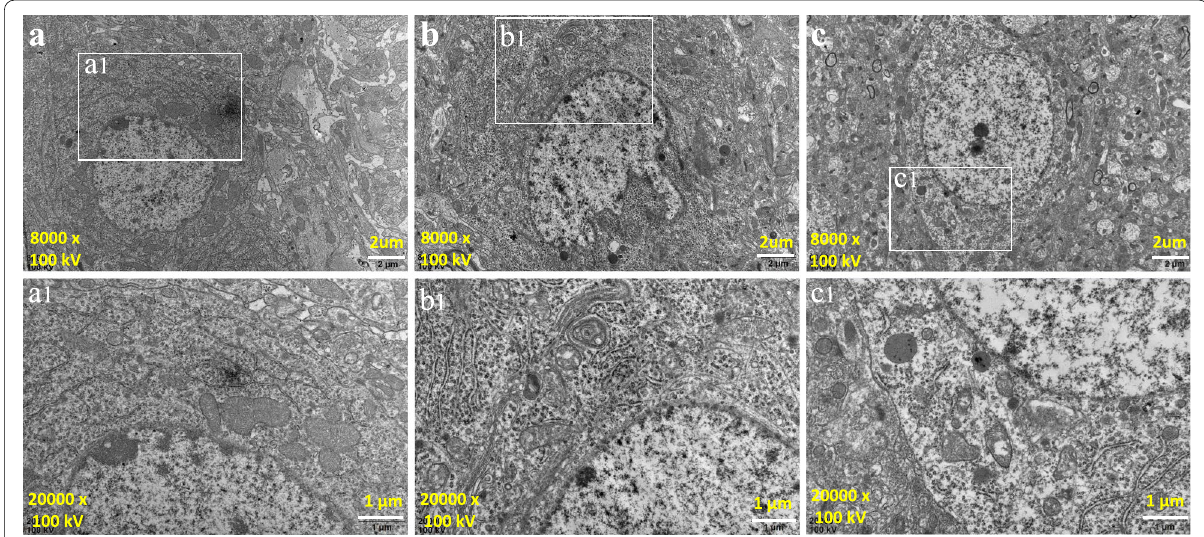
Fig. 6 Ultrastructural changes of nucleus and mitochondria in neurons. ( a ) Hippocampal neurons and mitochondria in control rats. ( b ) Ultrastructural changes of nuclei and mitochondria in hippocampal neurons. ( c ) Compared to the epilepsy model group, the 50 mg/kg OSI-906 group showed less damage to the mitochondria and nuclei. a , b and c are magnified 8,000 times, and a1 , b1 and c1 are magnified 20,000